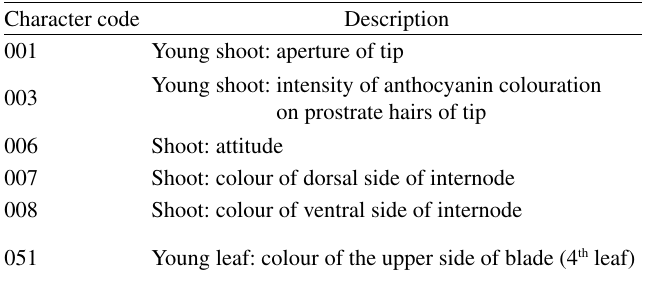
Table 2 - List of characteristics selected for the description of observed cultivars. The codes are in line with OIV guidelines (OIV, 2009)